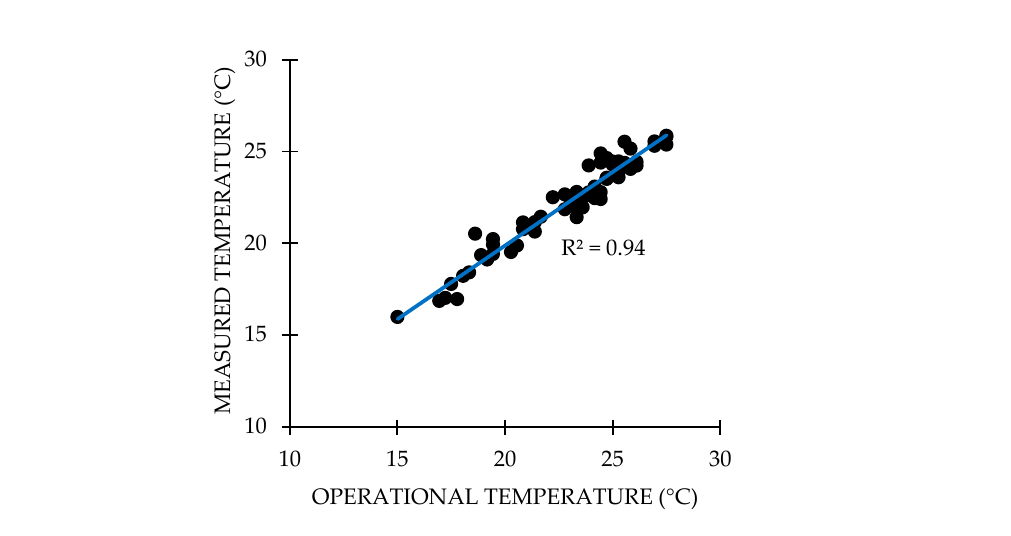
Figure 4. The correlation between the operational and measured temperatures.